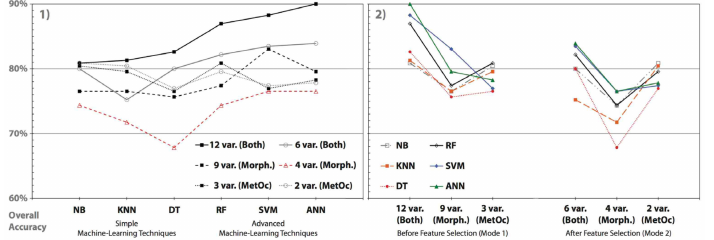
Figure 7. Overall-accuracy results from the 36 data-driven machine-learning (ML) classification algorithms derived from the first three stages of our experiment (Section 2.1). Panel 1 on the left presents content focusing on the six traditional ML classification techniques: naive Bayes (NB), K-nearest neighbor (KNN), decision trees (DT), random forest (RF), support vector machine (SVM), artificial neural network (ANN)—Section 2.1.3. Panel 2 on the right illustrates the two feature- selection modes (before and after feature selection—Section 2.1.1) from the secondary comparison level (two vertical black boxes in Figure 2, Figure 5, and Figure 6). The three combinations of variables are: (i) both attribute types together (Combination 1: morphological (Morph.) and MetOc); (ii) geometry, shape, and dimension attributes (Combination 2: morphological information); and (iii) Meteorological and Oceanographic Parameters (Combination 3: MetOc)—Section 2.1.2. See Figure 6 and Section